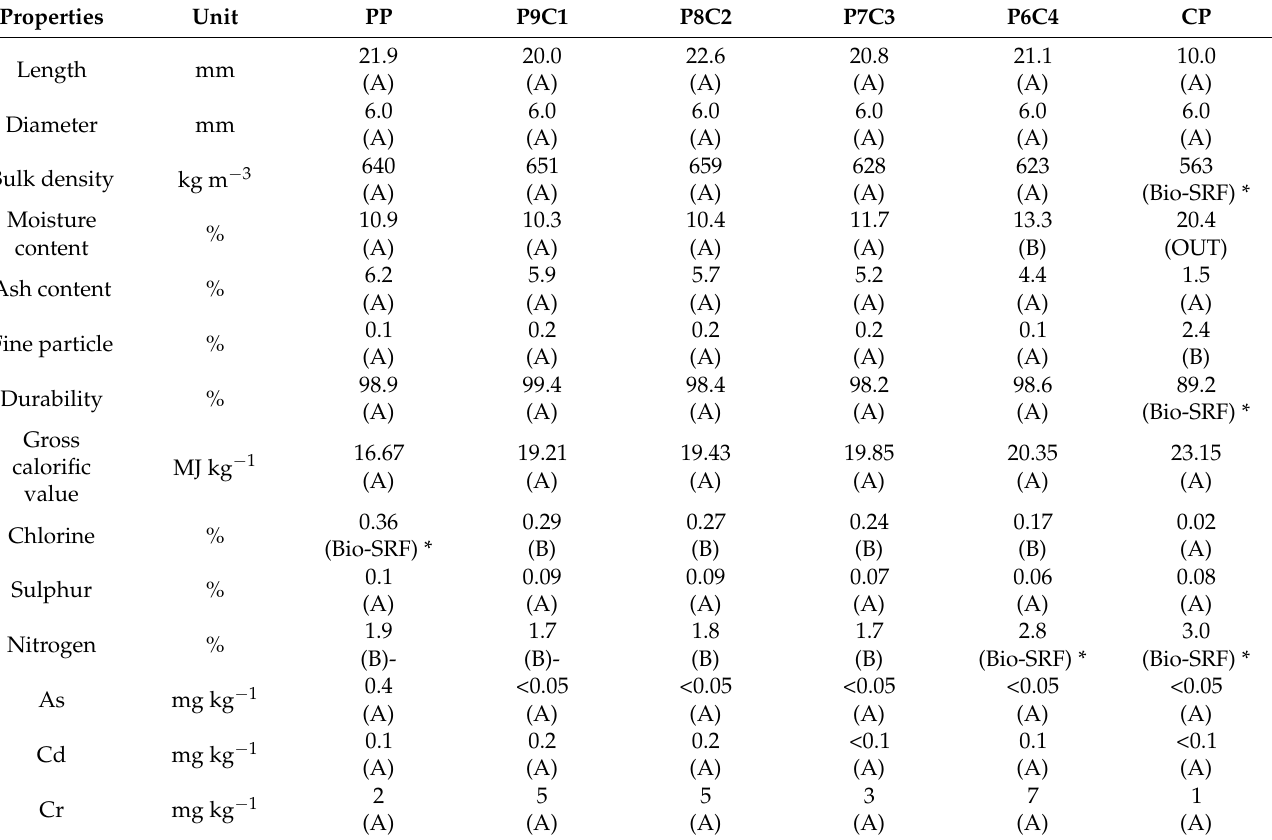
Table 5. Evaluation of agricultural by-product